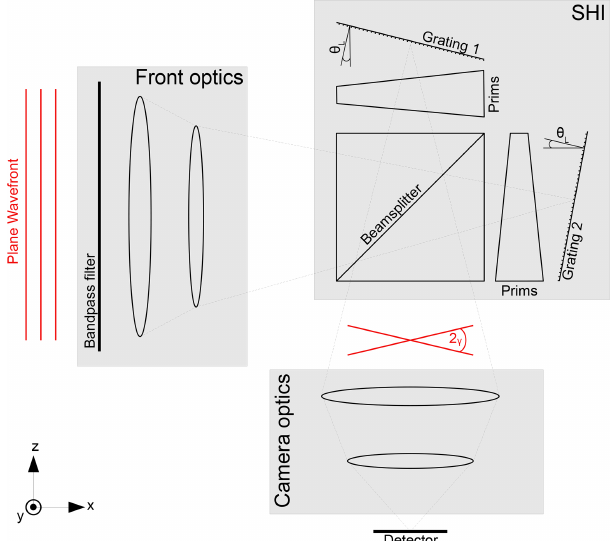
Figure 5. Schematic of the SHS